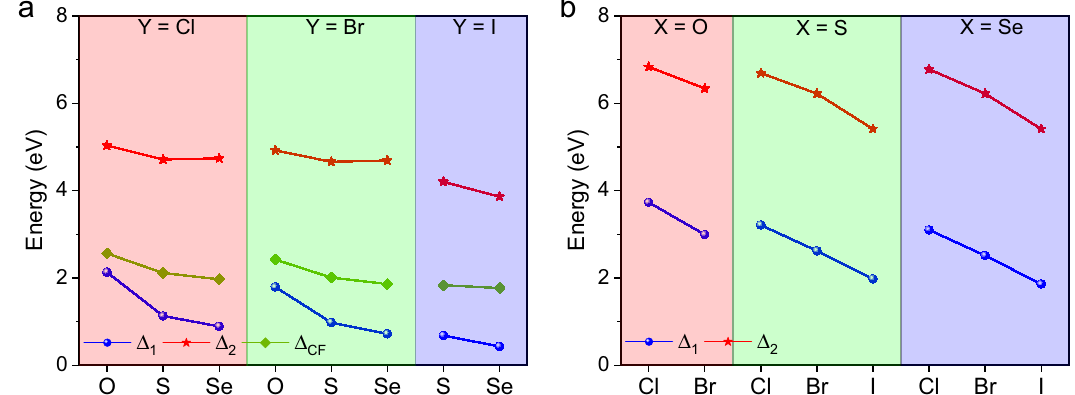
Fig. 4 Energy difference between different orbitals. Energy difference between e g - and p -orbitals ( Δ 1 ), t 2 g - and p -orbitals ( Δ 2 ) and e g - and t 2 g - orbitals ( Δ 3 ) for ( a ) different chalcogen (X) and ( b ) halogen atoms (Y).